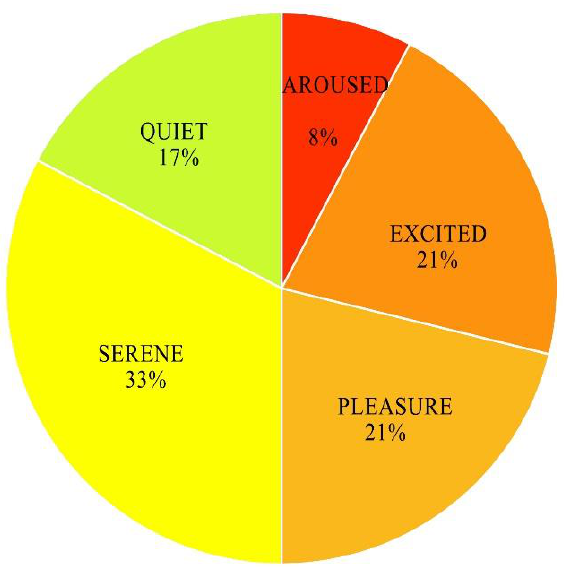
Figure 8 - Average emotional states in the